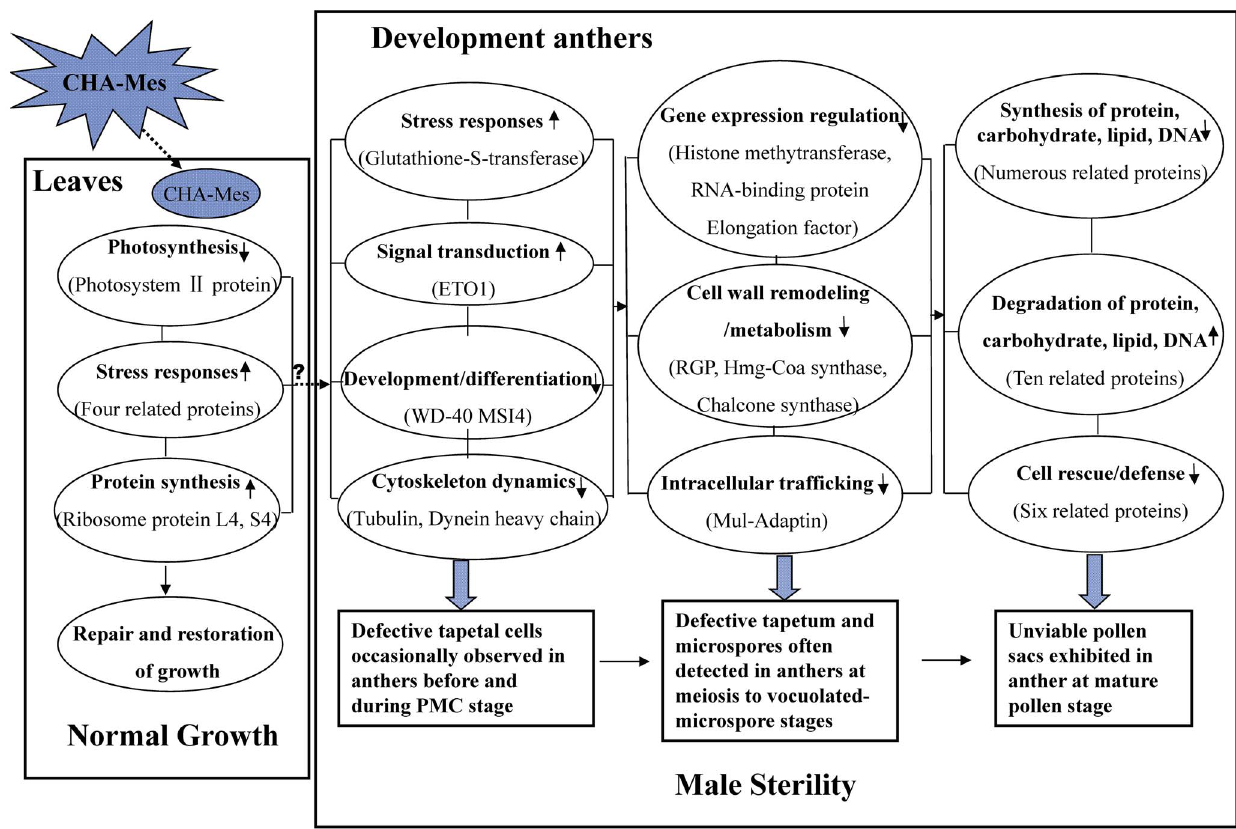
Figure 5. A simple model of CHA-MES-induced male sterility in rapeseed. Only some important differentially expressed proteins in leaves and developing anthers are listed in parentheses (see text for details). q in ovals means up-regulation; Q in ovals means down-regulation. Three piles of oval in the ‘Developing anthers’ box exhibited changes in biological processes in small buds with anthers before and during the pollen mother cell stage, anthers from medium buds from meiosis to the vacuolated-microspore stage, and anthers from large buds from the vacuolated- microspore to the mature-pollen stages, respectively. Three rectangles in the ‘Developing anthers’ box showed the cytological features observed in the three corresponding anther developmental stages. ‘?’ in the ‘Leaves’ box represents unclear signals.